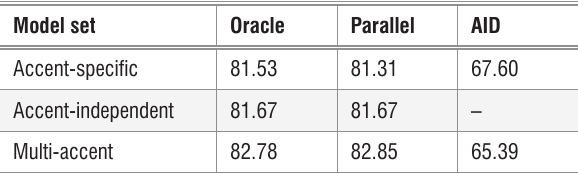
Recognition performance of the oracle and parallel configur- ations when applying per-utterance accent identifi cation (AID). Average word recognition accuracies (%) are given for oracle and parallel configurations and per-utterance accuracies (%) are given for AID.